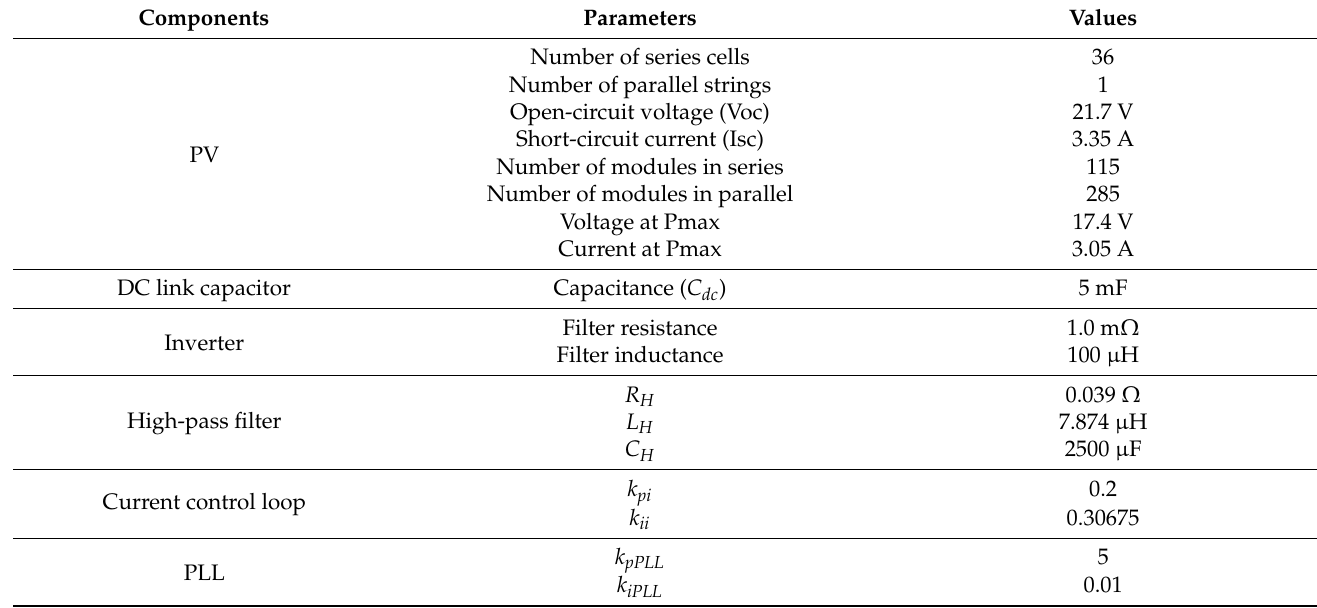
Figure 7. Block diagram of the inverter controls used for the PV system. Table 1. Parameters for solar PV